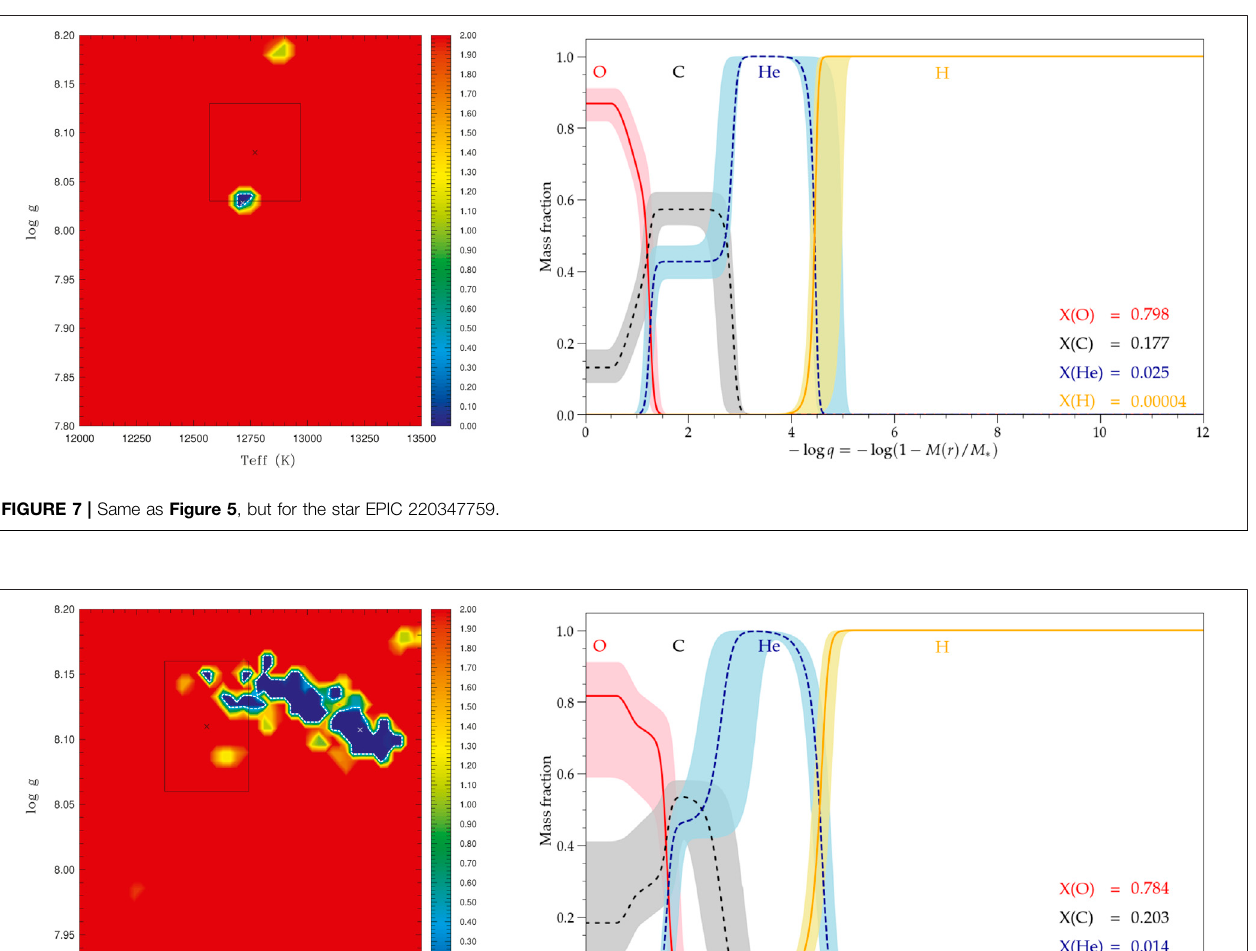
Frontiers in Astronomy and Space Sciences |